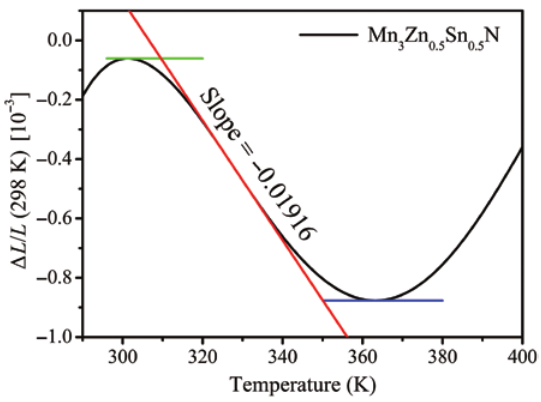
Figure 2: Linear thermal expansion of the thermal expansion com- pensator Mn